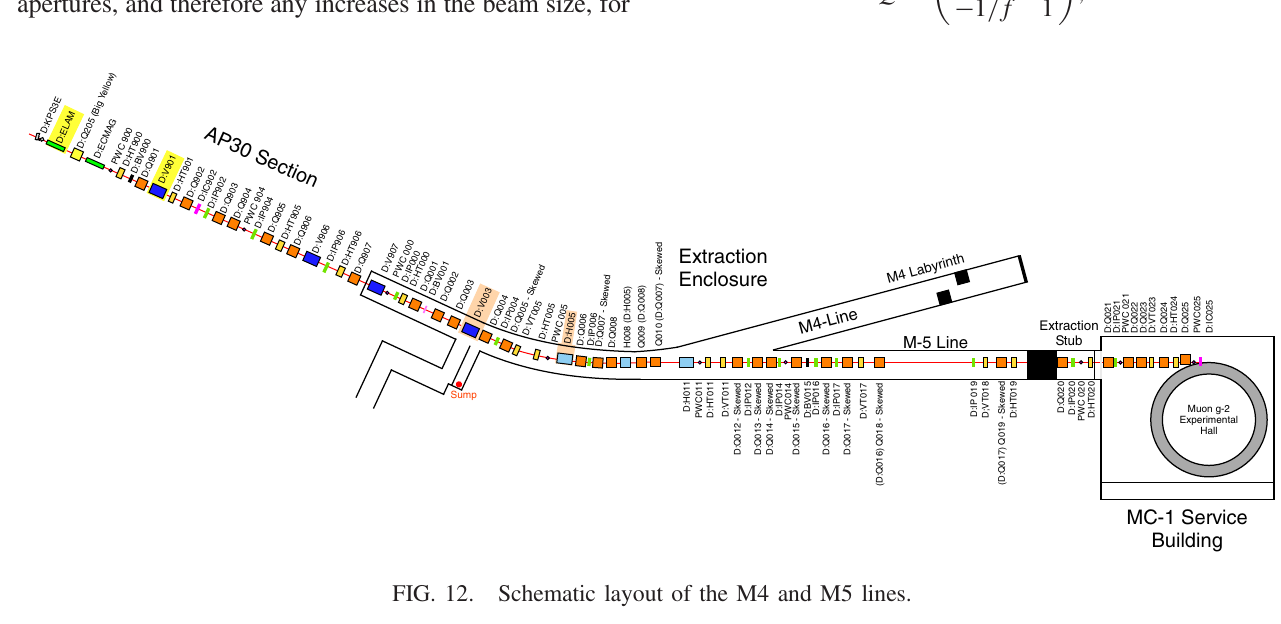
FIG. 12. Schematic layout of the M4 and M5